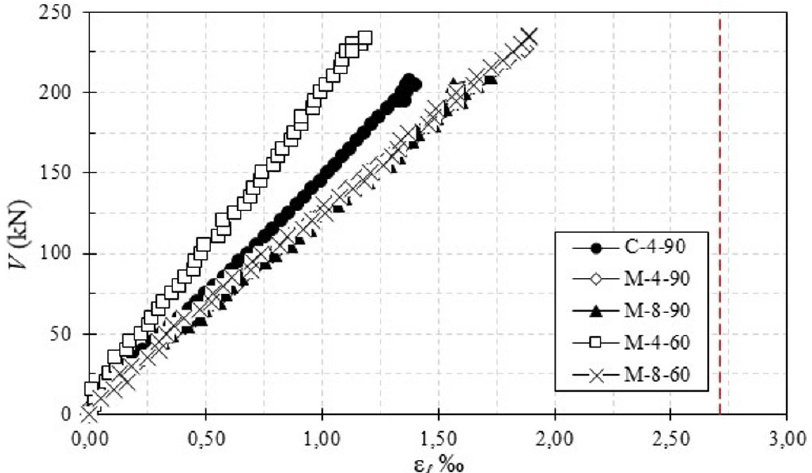
Figure 9 – Shear force versus Strains of the flexural reinforcement of the beams.